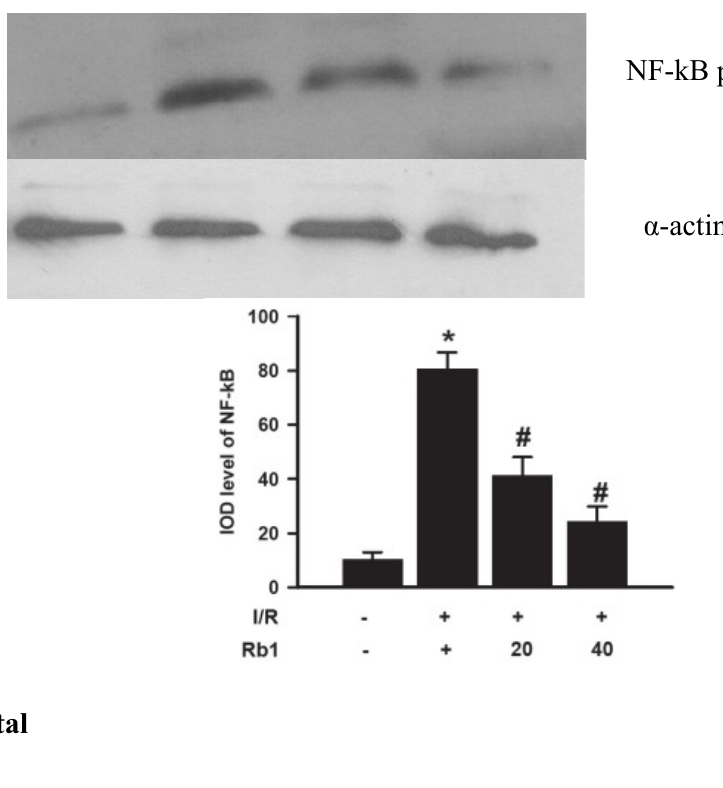
Figure 9. Effects of Rb1 on NF-kB activation of lung tissue after intestinal